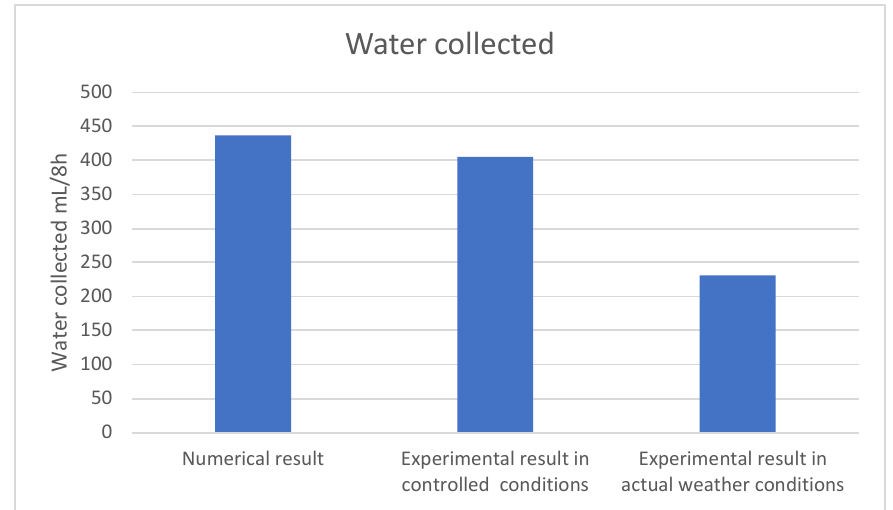
Figure 12. Comparison between the numerical and experimental results.